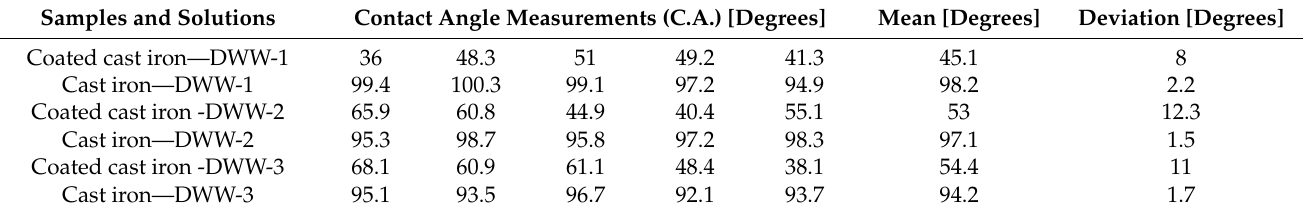
Table 2. The values of the contact angle for the studied samples in three different wastewaters. Samples and Solutions Contact Angle Measurements (C.A.) [Degrees]